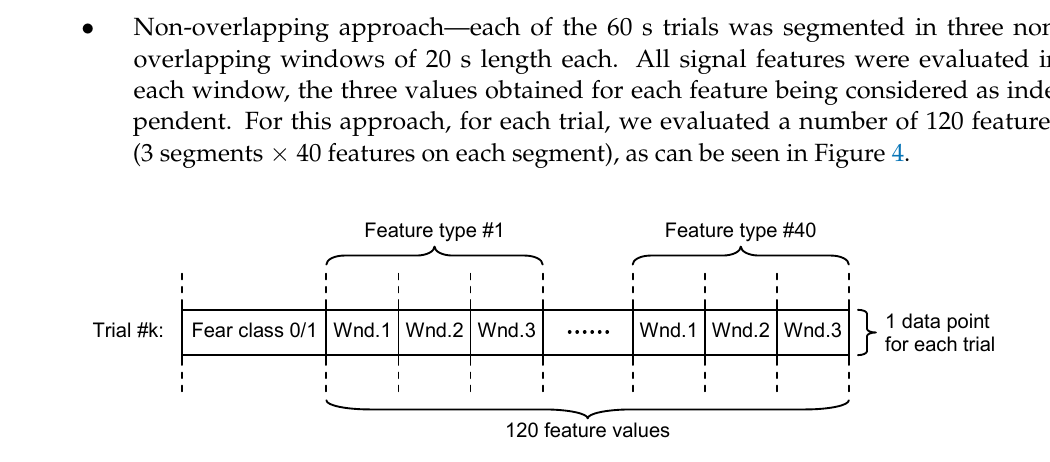
Figure 4. Dataset structure for non-overlapping approach.